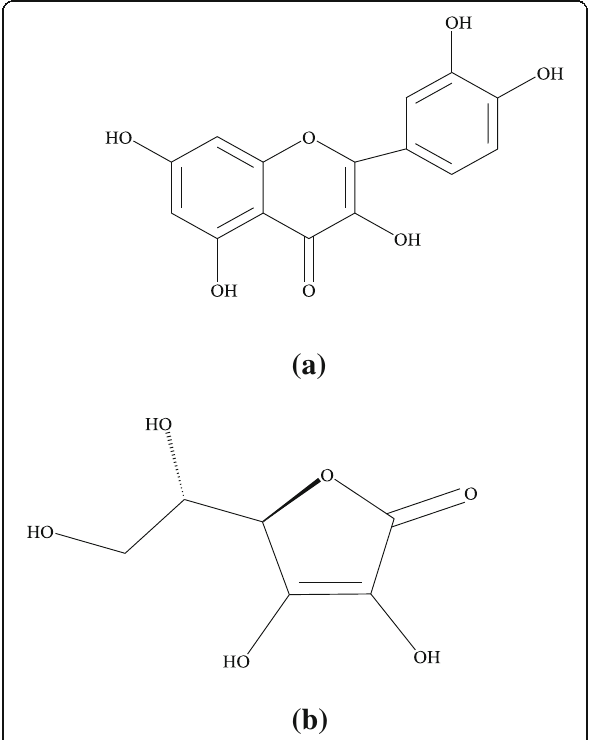
Fig. 2 a Chemical structure of quercetin (b) Chemical structure ofascorbic